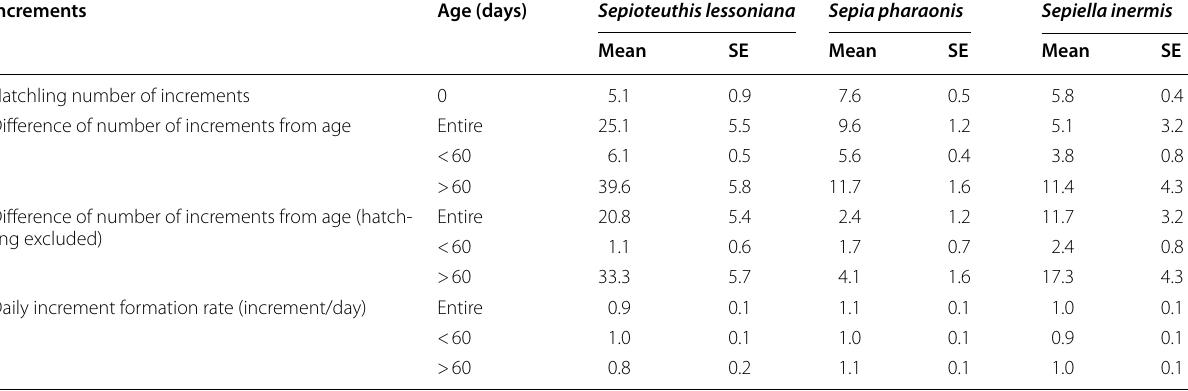
Table 1 Number of increments at different growth stages of cultured cephalopods. (28 ‒ 30 °C) Increments